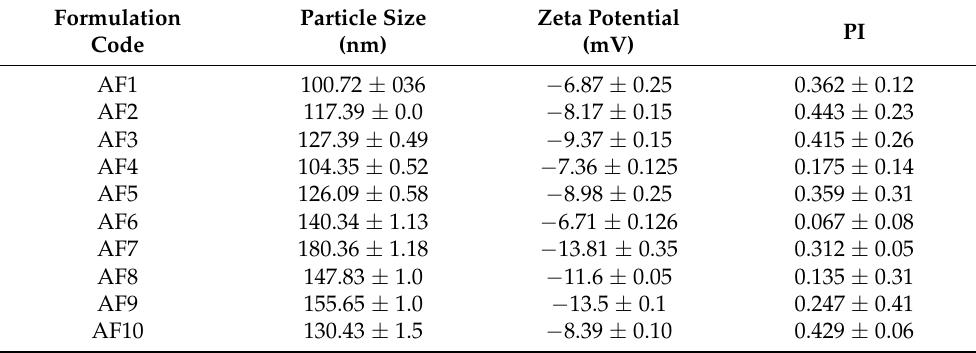
Table 3. Mean particle size (nm), zeta potential (mV), and polydispersity index (PI) of different ALP